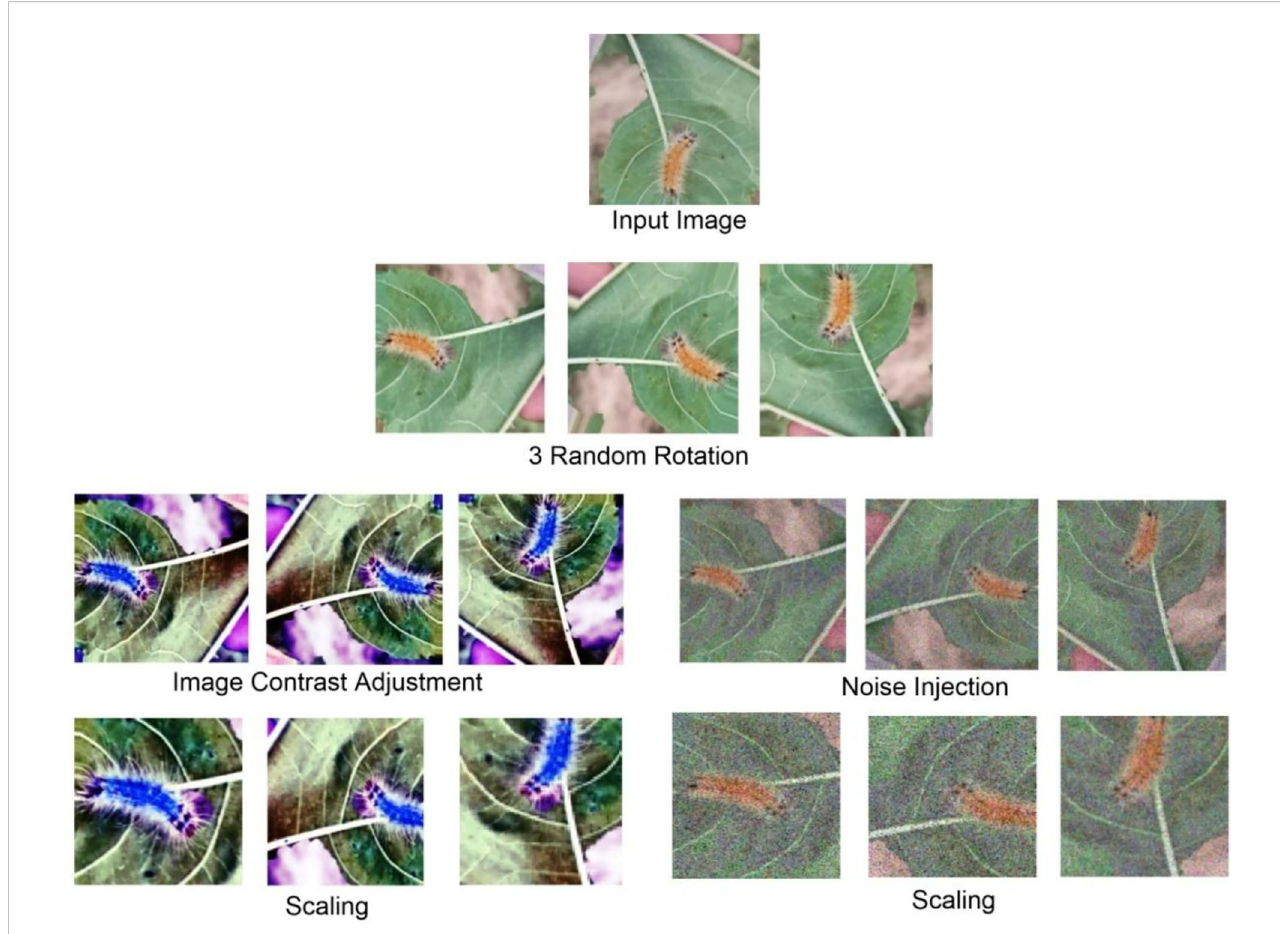
FIGURE 3 Augmented data of bihar hairy caterpillar